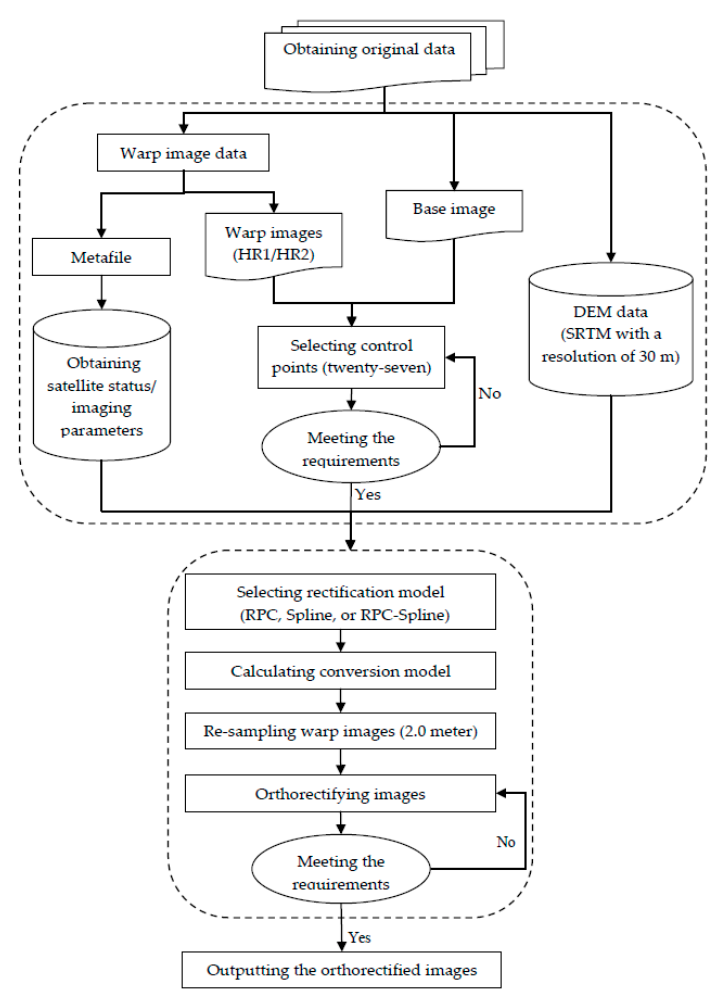
Figure 2. The procedure used for orthorectifying images in this study.